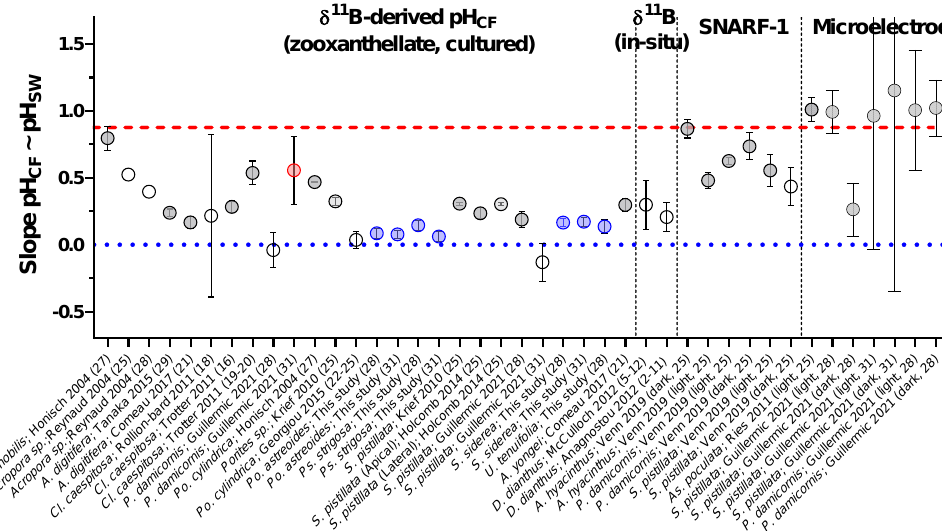
Figure 8. The sensitivity of pH CF to pH SW within the coral species studied here and reported in the literature. Y-Axis is the slope of the relationship between pH CF and pH SW , with a value of 1 showing that change in pH CF directly tracks the magnitude of the change in pH SW , and a value of 0 indicating perfect control over coral pH CF amidst variable pH SW . On X axis, numbers in parenthesis are the temperature of the experiment. Previously published data used in the figure are available in Table S12 alongside citations for data